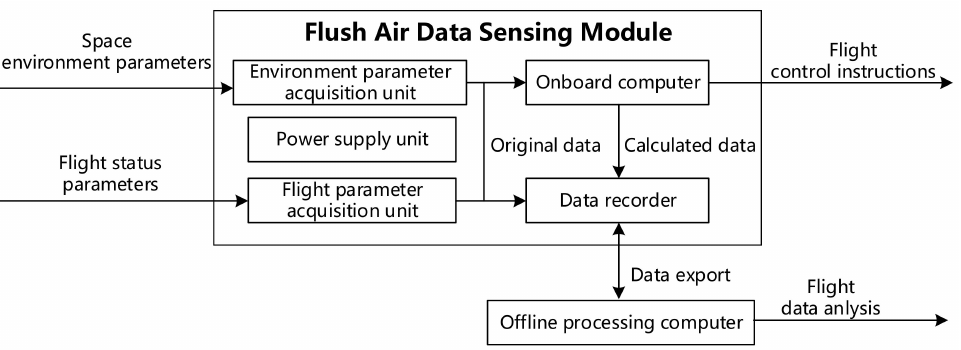
Figure 5. Working schematic diagram of the flush air data sensing module.